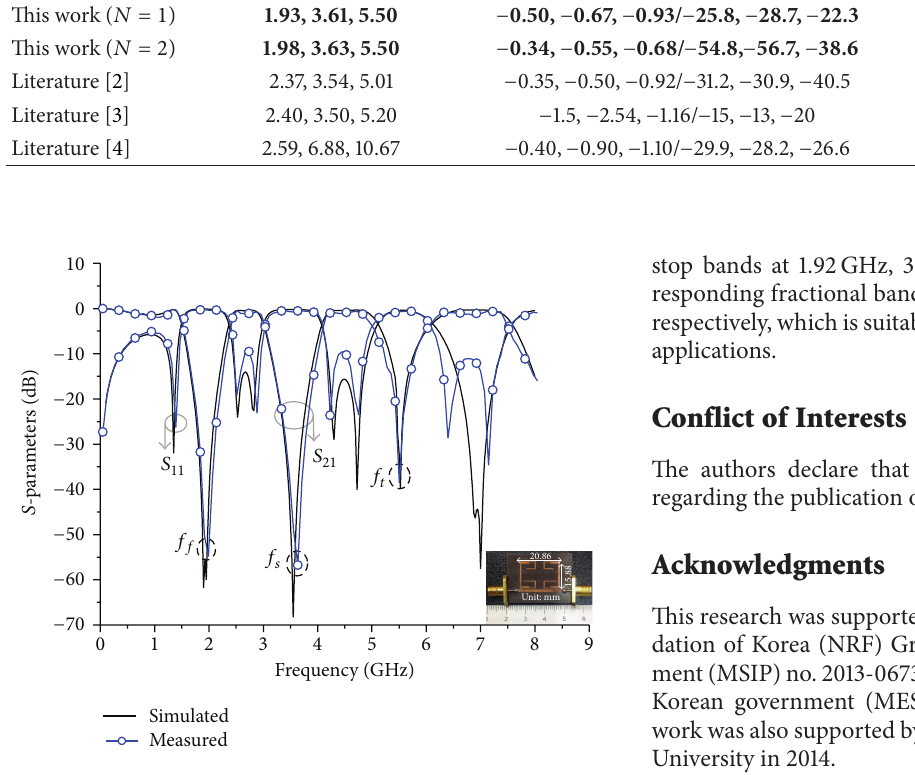
Figure 11: Photograph of the fabricated TBBSF (20.68 mm × 15.88 mm) and results of order 𝑁 = 2